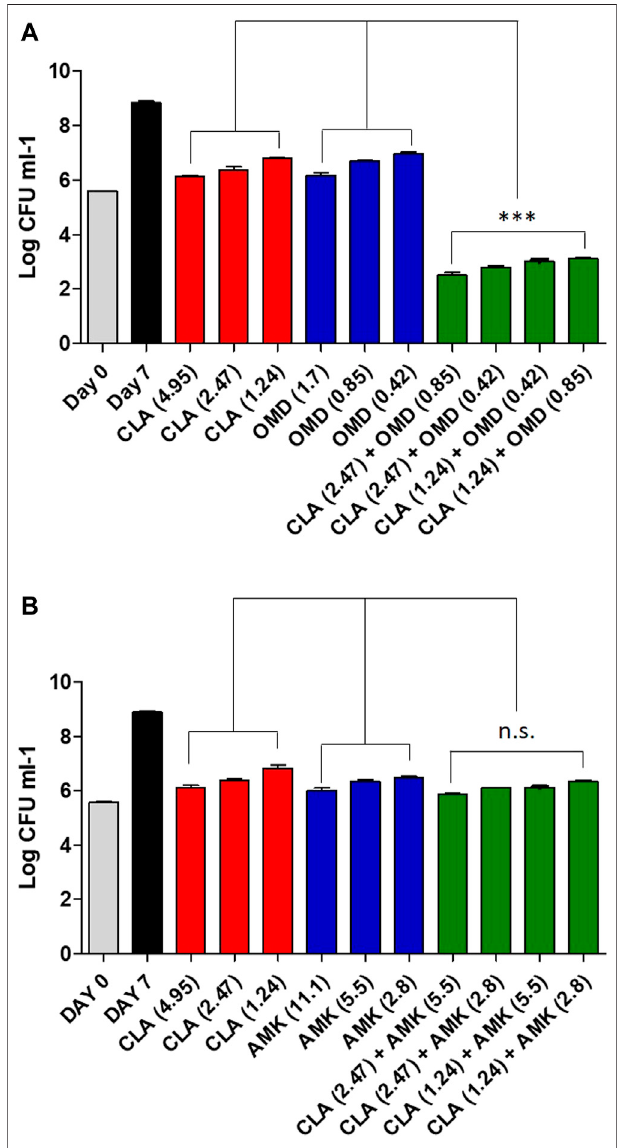
FIGURE 2 | Estimation of bactericidal effect by CFU counts. Mab was grown in the presence of different concentrations of CLA alone or in combination with decreasing concentrations of OMD (A) and AMK (B) . Following 7 days of culture, Mab were plated to 7H10 agar plate to determine live bacteria. The DMSO treated bacteria were also plated on day 0 and on day 7. One-way ANOVA with Tukey ’ s multiple comparison test was used to compare the means across multiple groups (** p < 0.01; *** p < 0.001).